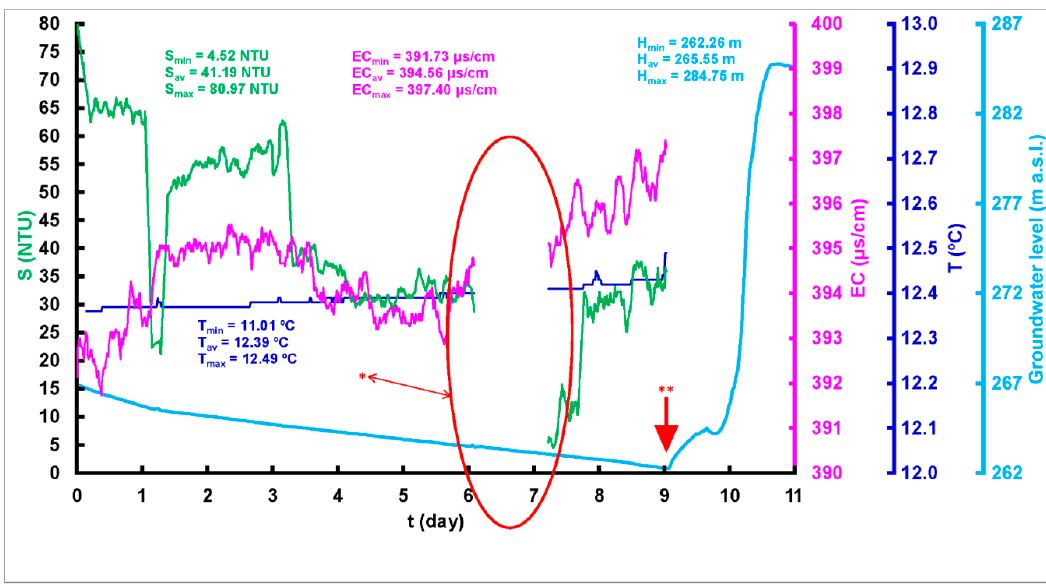
Figure 10. Pumping test in 2009: Time series of turbidity S (NTU), groundwater temperature T (°C), and electrical conductivity EC ( μ S/cm) measured every 2 min during the period 16 September 2010 at 6 h 23 min 49 s–25 September 2010 at 6 h 52 min 24 s (868 data). * Period when datalogger was out of water due to technical problems. Groundwater levels on separate axis (pumping rate constant, 180 L/s), red arrow shows the end of the pumping.